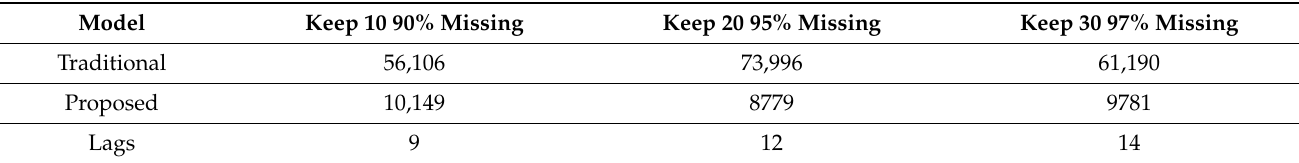
Table 2. Average validation error for two models with missing quality data and 30% random output data.